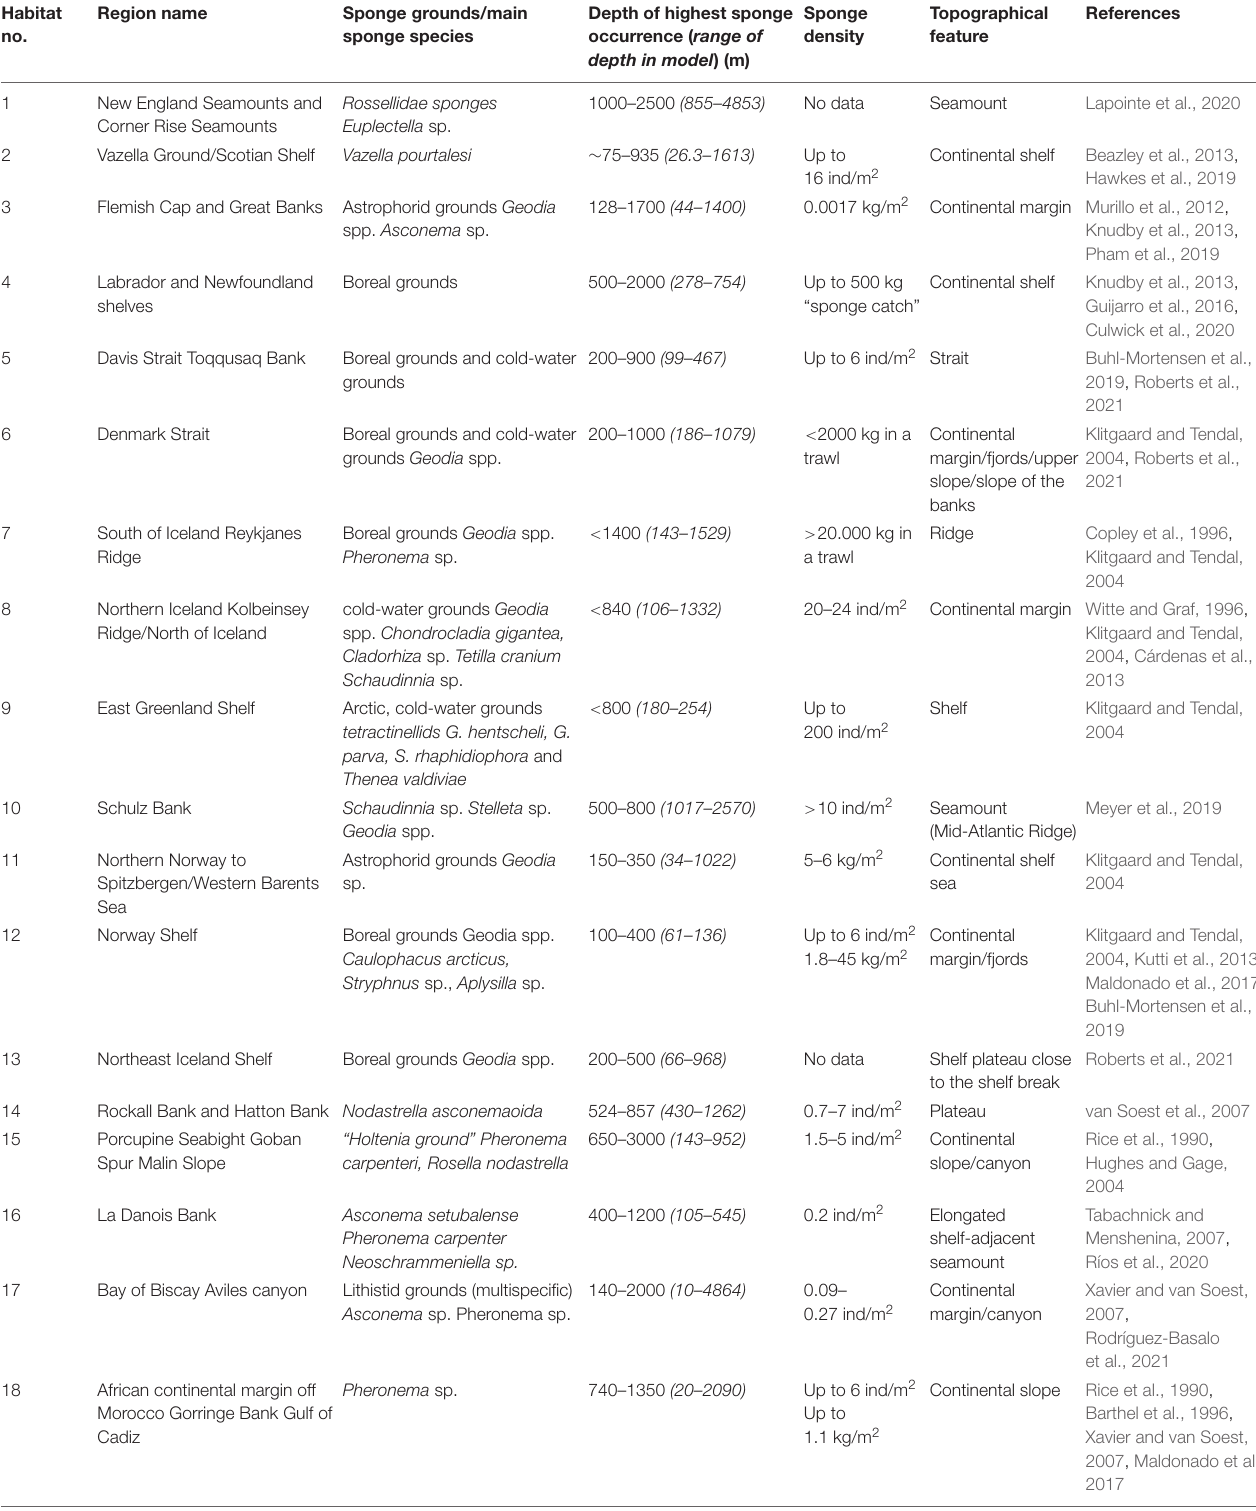
TABLE 1 | The habitat number given in our study and the corresponding name, sponge grounds/main sponge species, depths of highest sponge occurrence, sponge density, topographical feature, and related references. Habitat